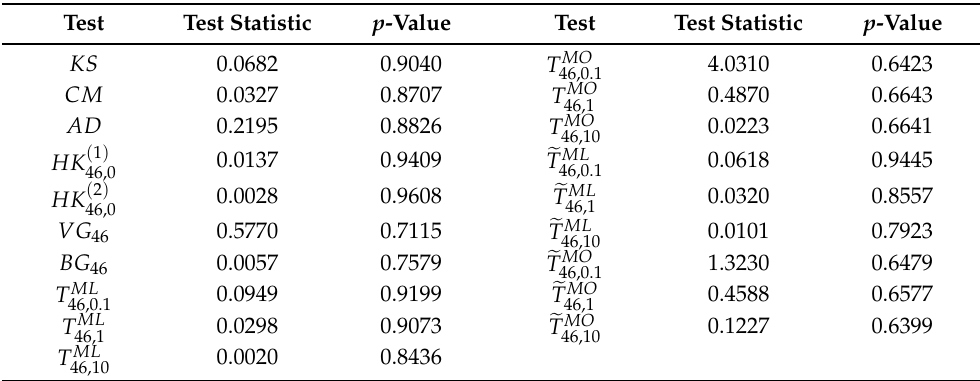
Table 5. Values of the test statistics and p -values for the repair time example.